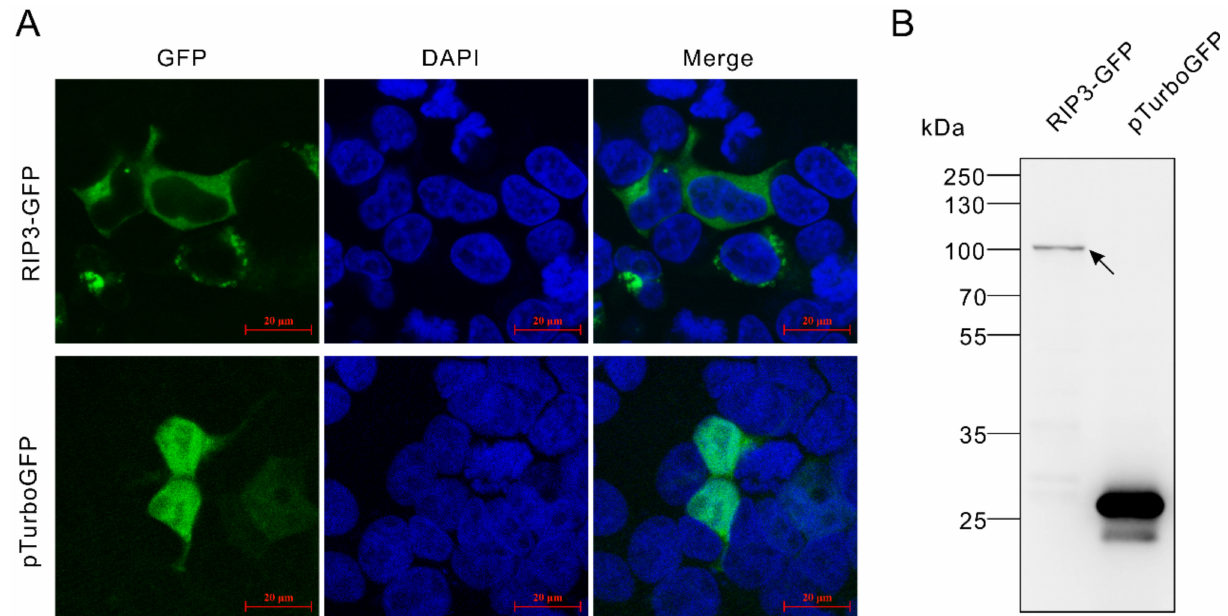
Figure 4. Subcellular localization of Lc -RIP3. ( A ) HEK 293T cells were transfected with pTurbo-RIP3-GFP and pTurboGFP- N (vector control), respectively. At 24 h post-transfection, the cells were stained with DAPI and then examined and photographed under a confocal microscope. ( B ) The confirmation of the successful expression of the RIP3-GFP and pTurboGFP fusion proteins was conducted by a Western blotting analysis using an Anti-TurboGFP